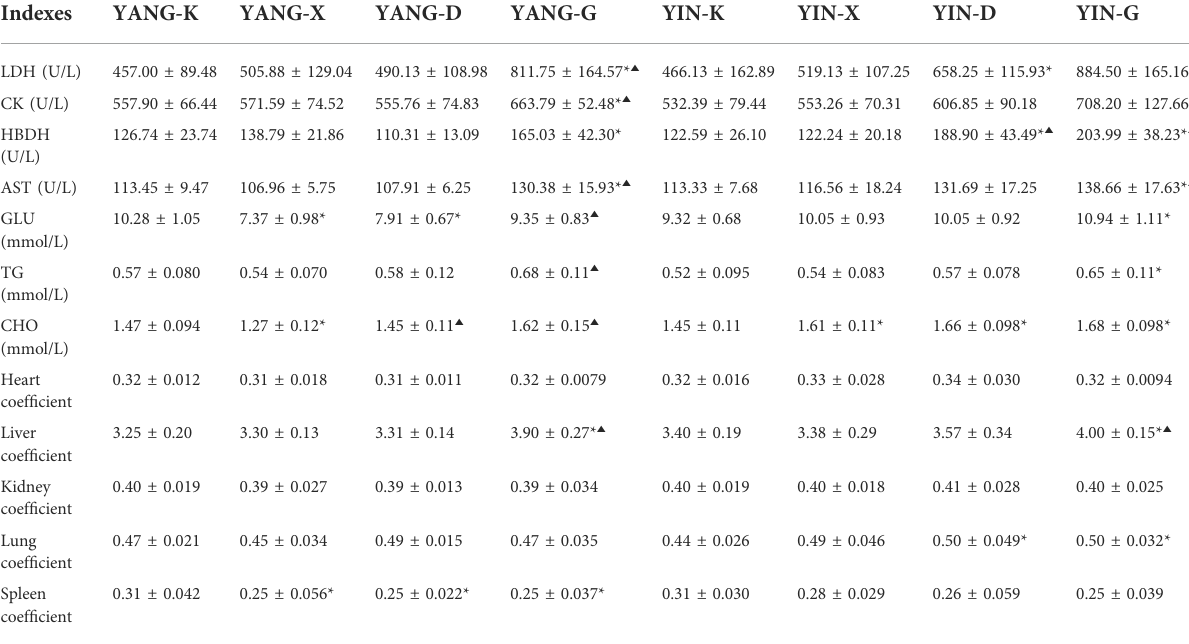
TABLE 6 Results of serum biomarkers and organ coef fi cients of rats in different groups ( n = 8, ‾ x ± s ).